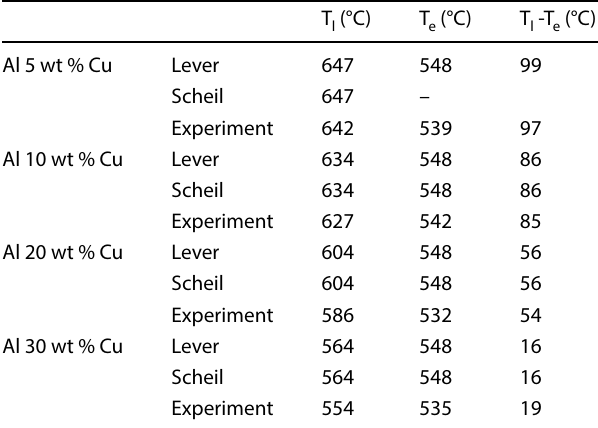
Table 1 Thermodynamic and experimental data for liquidus and eutectic temperatures and their